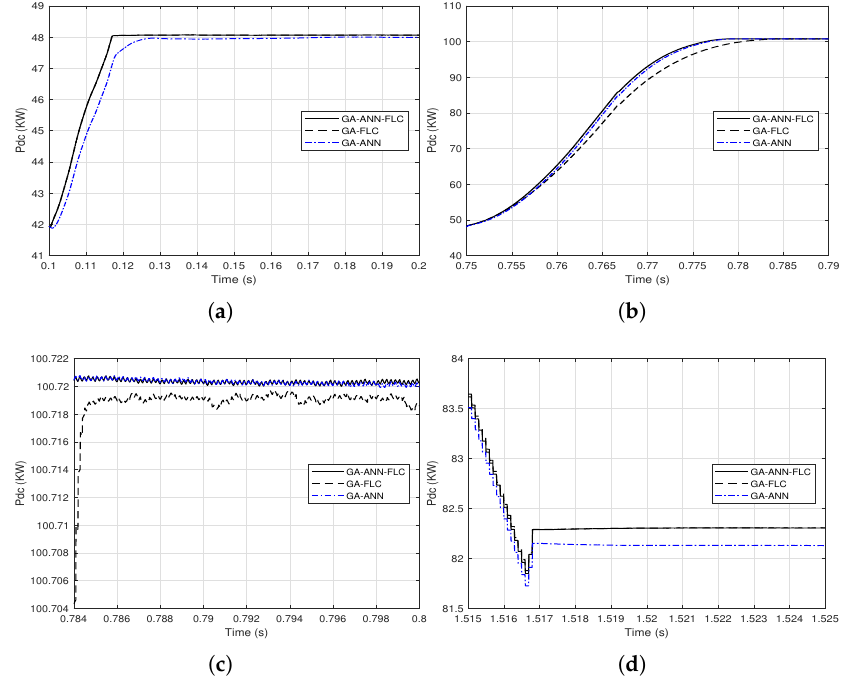
Figure 17. Close views of combining the output DC power response from the GA-FLC and the GA- ANN based MPPT methods based on the environmental conditions G and T c for their step variations ( a ) from 0.1 to 0.2 s; ( b ) from 0.75 to 0.79 s; ( c ) from 0.784 to 0.8 s; ( d ) from 1.515 to 1.525 s. Table 2. A quantitative evaluation of the proposed MPPT methods in terms of the produced energy and the rise time. Step Variations of G and T c Ramp Variations of G and T c Output Energy (KJ) Rise Time (s) Output Energy